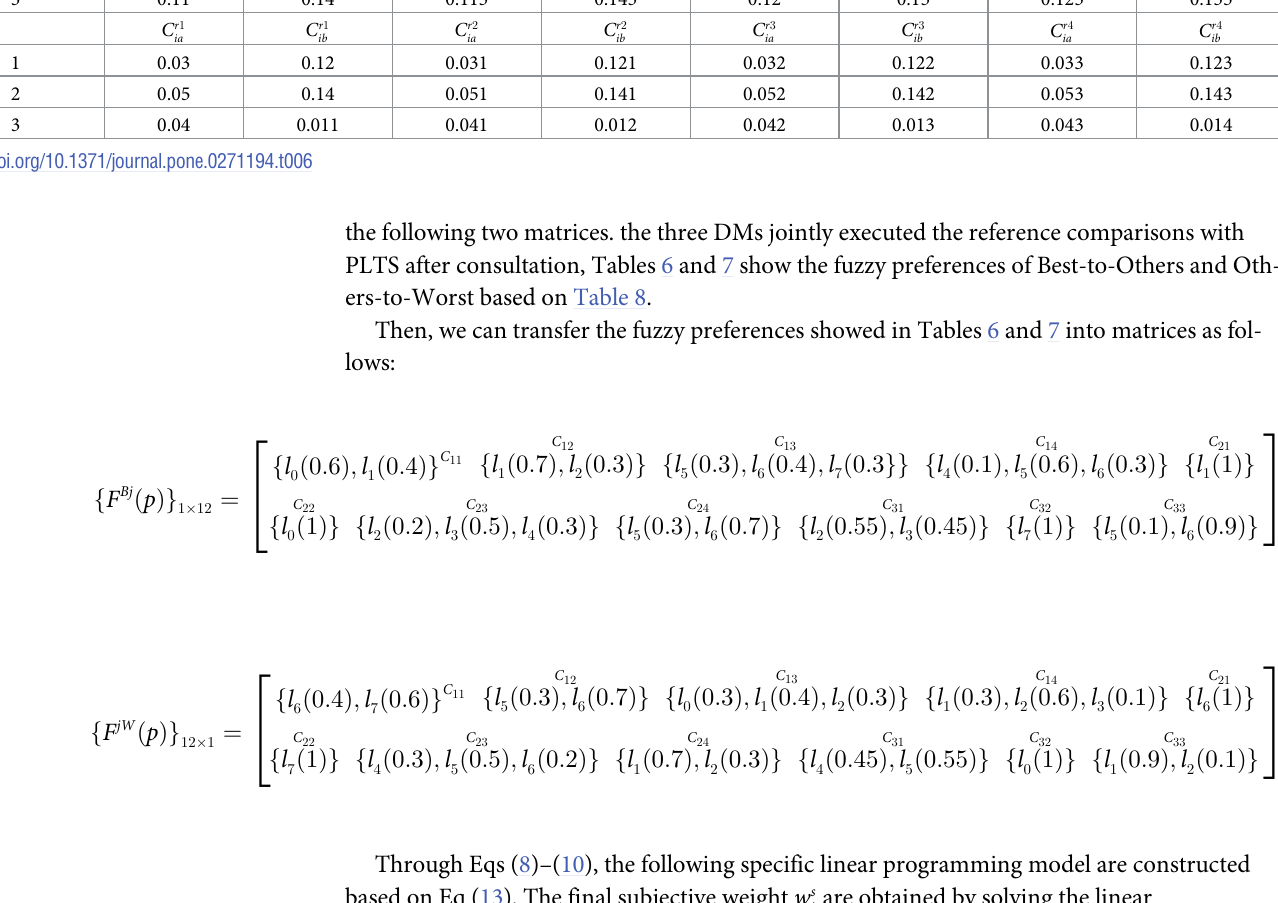
are obtained by solving the linear j